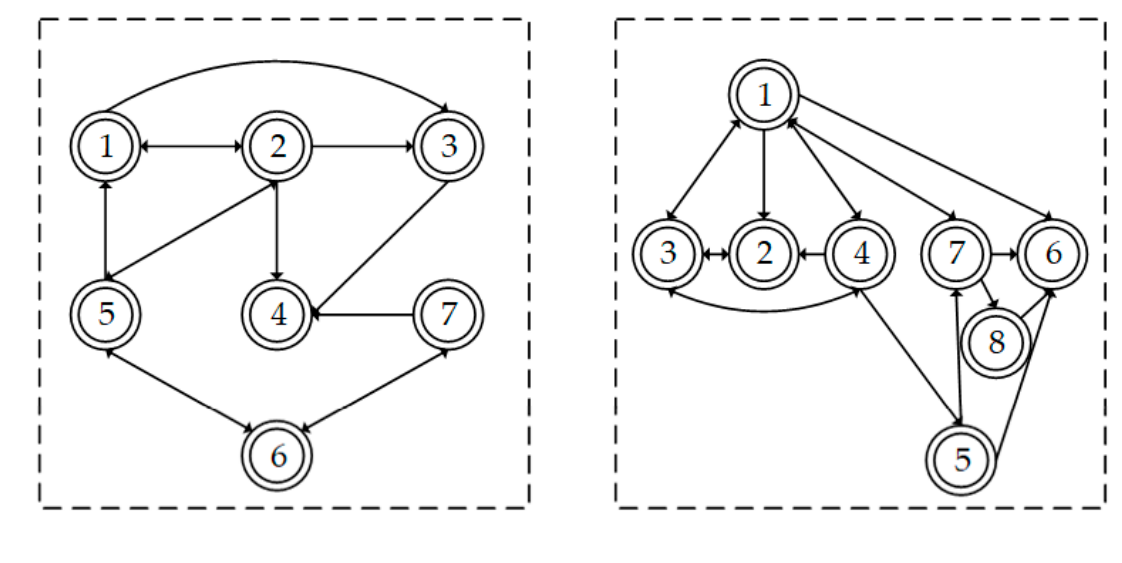
Figure 9. Simplification of carbon emission efficiency correlation networks in two major urban agglomerations.